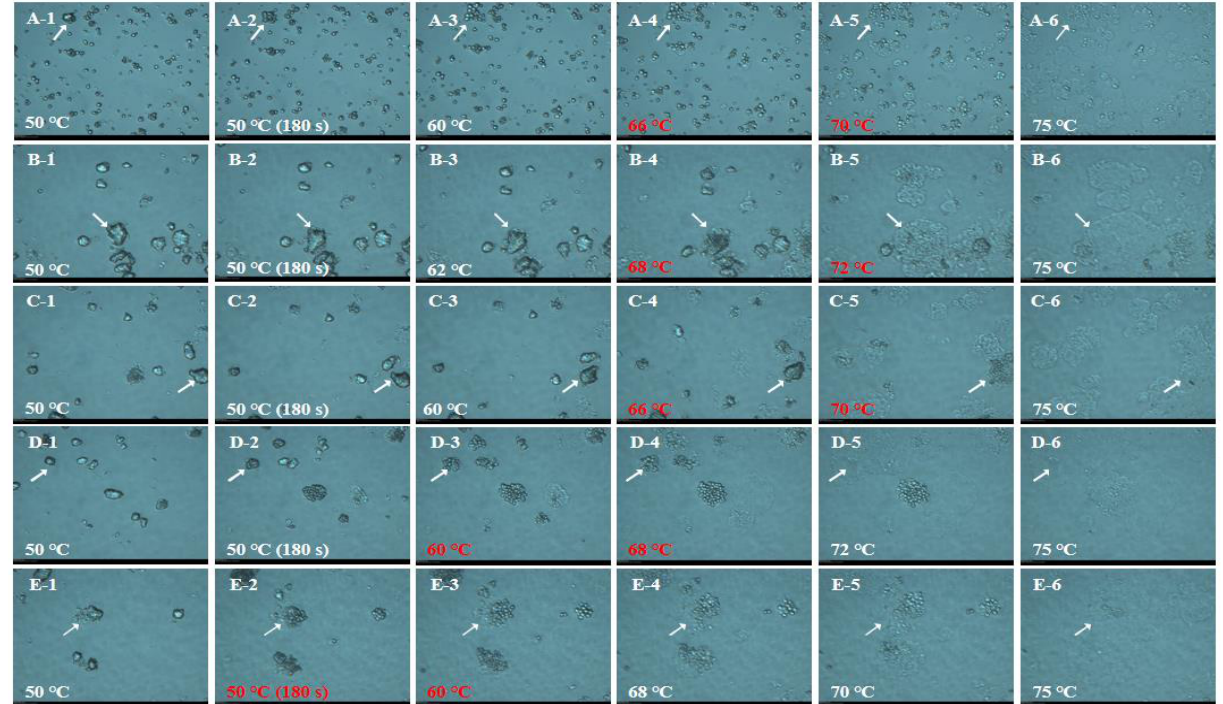
Figure 2. The dynamic gelatinzation process of IWR. “ A − 1 to A − 6 ” , “ B − 1 to B − 6 ” , “ C − 1 to C − 6 ” , “ D − 1 to D − 6 ” and “ E − 1 to E − 6 ” stand for the dynamic gelatinzation process of IWR − W, IWR − D − 60, IWR − D − 120, IWR − D − 200 and IWR − D − 320, respectively. The temperature represents the swelling temperature of the sample.